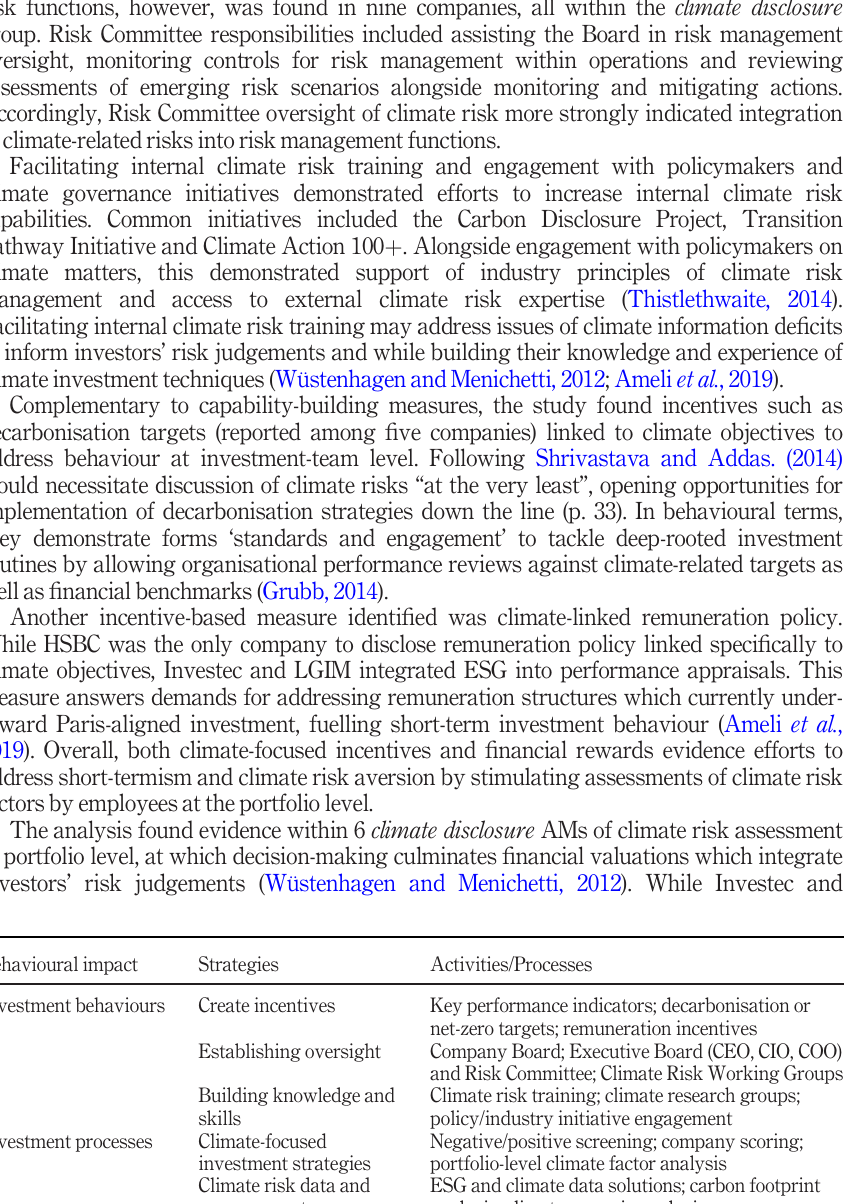
Table 2. Climate